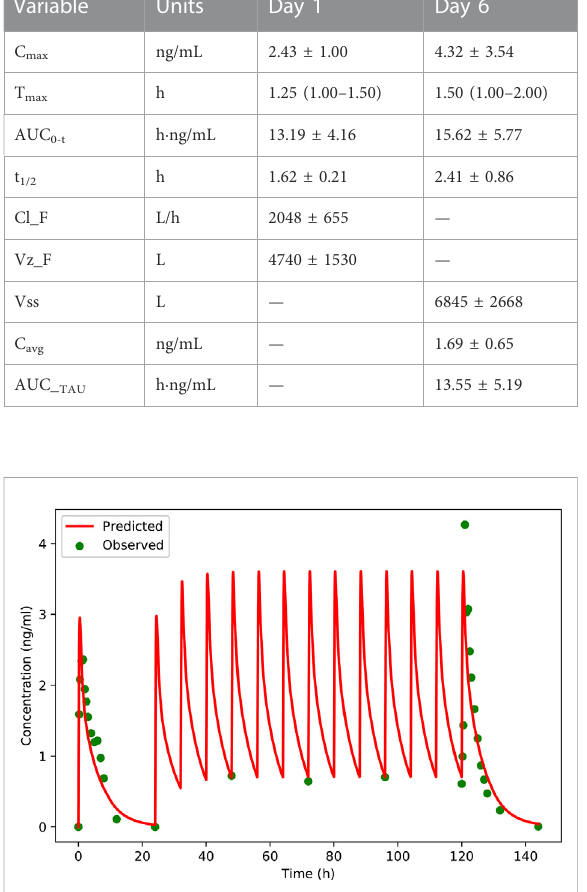
FIGURE 5 Predicted and observed plasma concentration-versus-time pro fi les of schaftoside after single- and multiple-dose of TFDS Capsules to healthy volunteers (two male and two female). Clinicallyobserveddataareshownasdots;solidlinesindicate the model